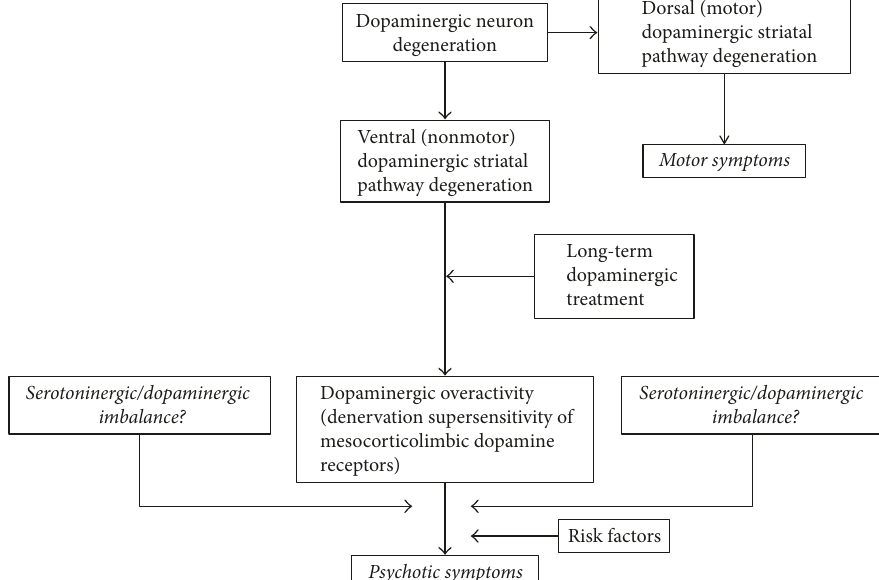
Figure 1: Proposed neurochemical pathways in the pathogenesis of psychosis in PD. DA, dopamine. Reference: Papapetropoulos et al., 2005